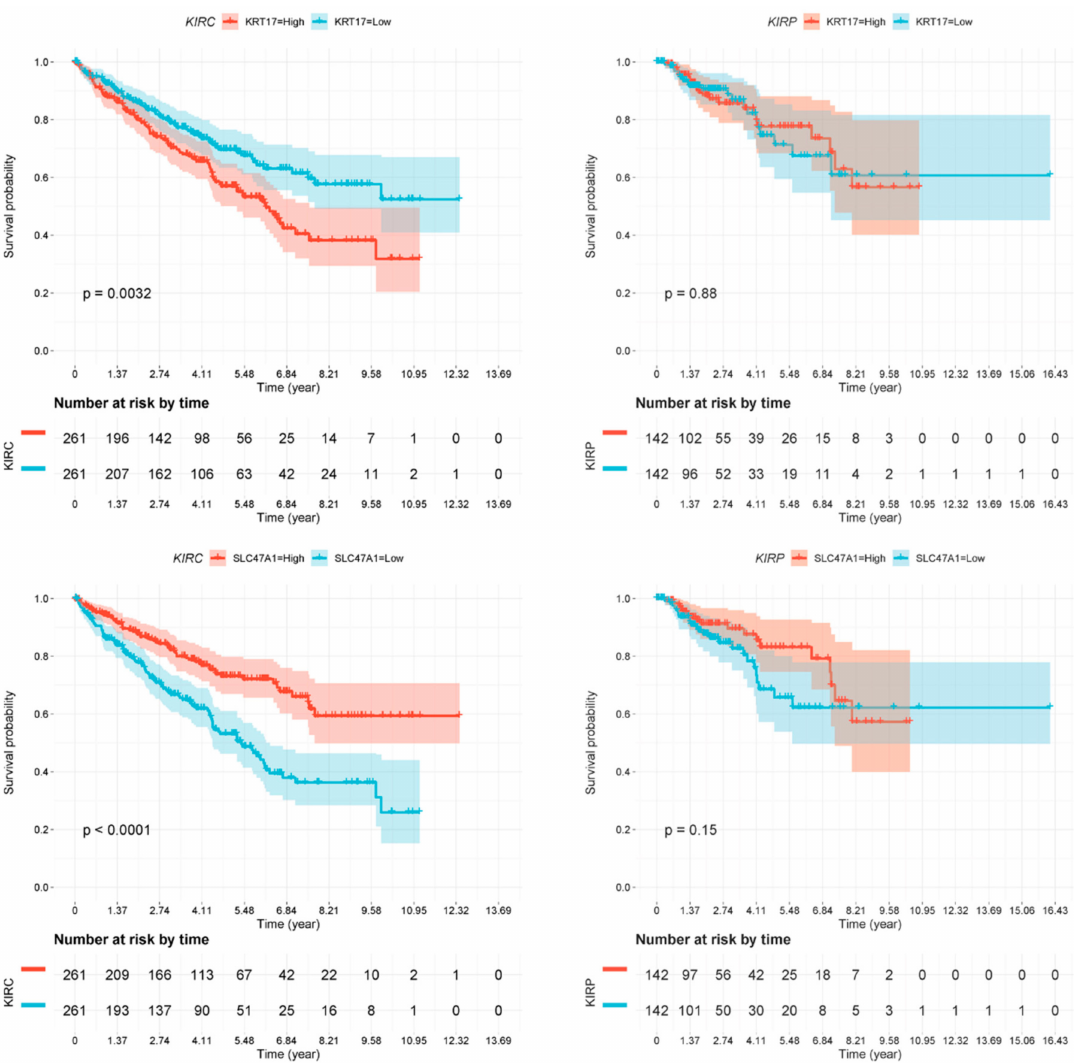
Figure 6. Kaplan-Meier analyses. Association of deregulated gene expression in CDCs with overall survival in clear cell renal cell carcinoma (ccRCC patients; KIRC dataset) and in papillary renal cell carcinoma (pRCC patients; KIRP dataset). Expression of none of the genes was significantly associated with overall survival in pRCC patients. However, the expression of all genes but HK2 was significantly associated with overall survival, as shown for HK2 (nonsignificant), MARC2 ( p = 0.001), CUBN ( p ≤ 0.0001), KRT17 ( p = 0.0032), and SLC47A1 ( p ≤